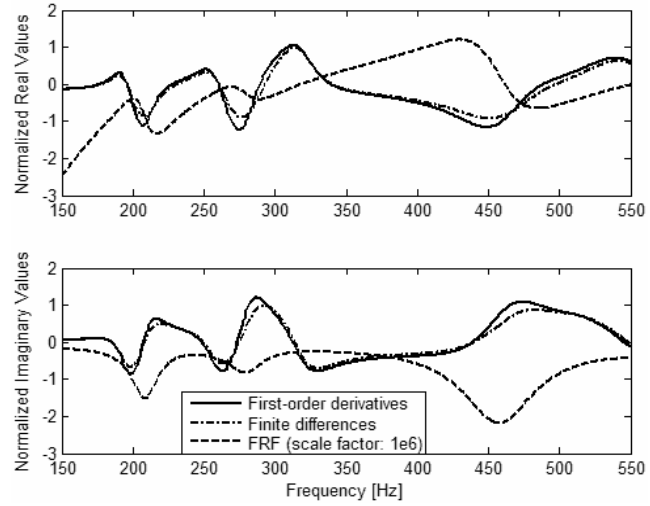
Fig. 6. Sensitivities of the FRF H II ( ω,T,p ) with respect to the thickness of the constraining